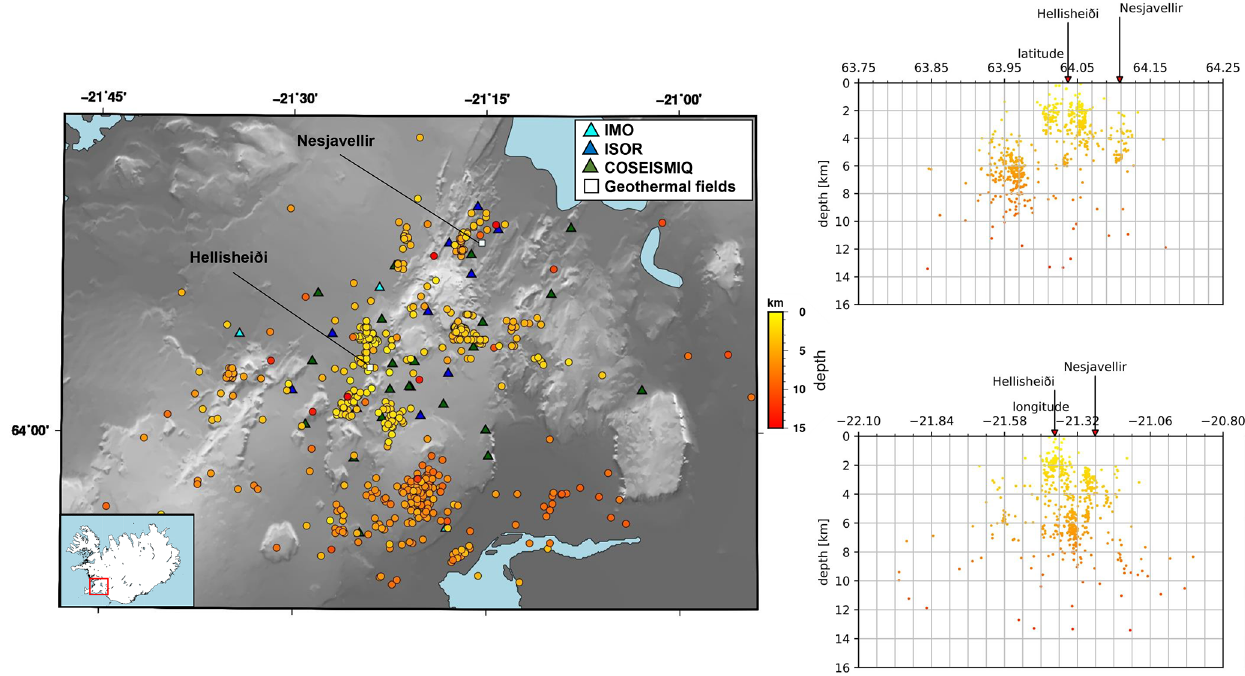
Figure 7. Map and two orthogonal NS and EW vertical sections of 637 earthquakes occurred between 22 December 2018 and 31 Jan- uary 2019. Located seismic events are color-coded according to depth, arrows in crsoss sections indicate the location of Hellisheidi and Nesjavellir geothermal plants, the coloured triangles represent the seismic stations of different networks.